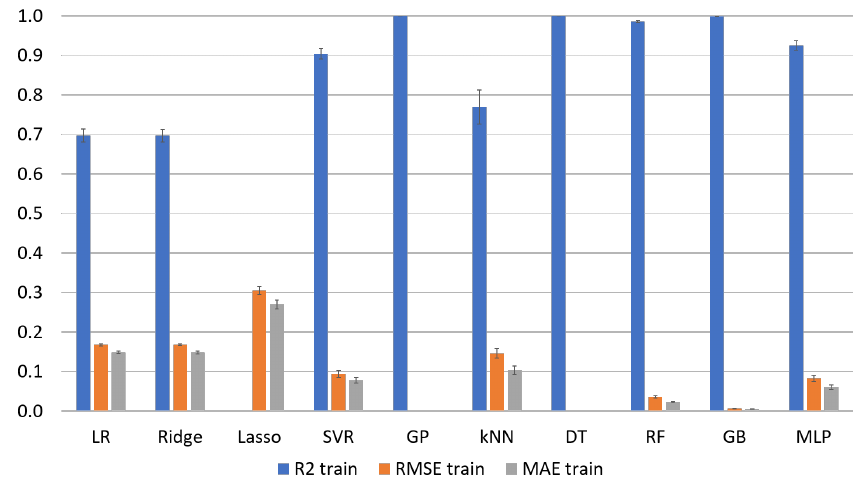
Figure 10. Train performances of the ten screened ML models (without HP optimization).